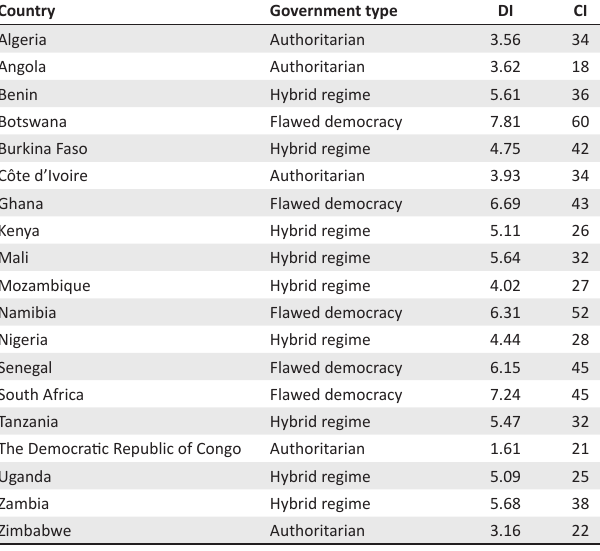
TABLE 2: Country by government type, democracy index and perceived level of corruption. Country